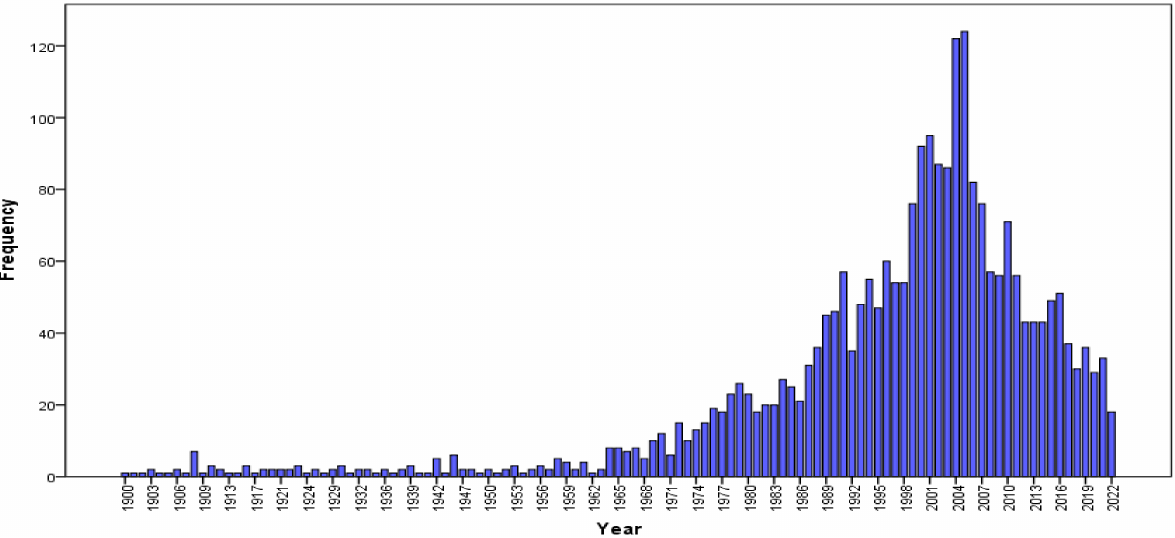
Figure 1. The number of disasters (all types) for analyzed period of 1900–June 2022 (source: authors’ work based on EM-DAT CRED database [18]).